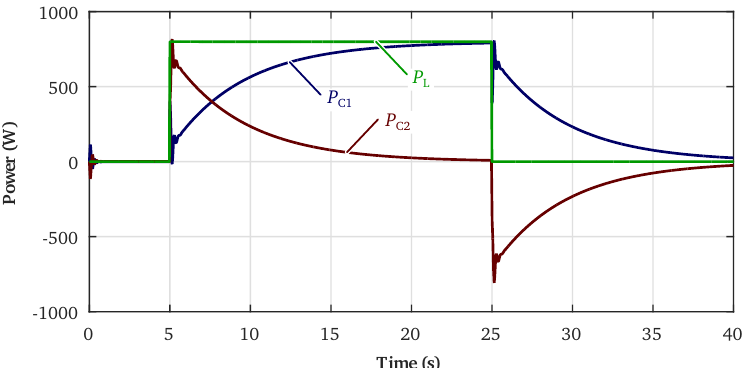
Figure 8. Supplied and load power with the proposed control configured for different dynamic